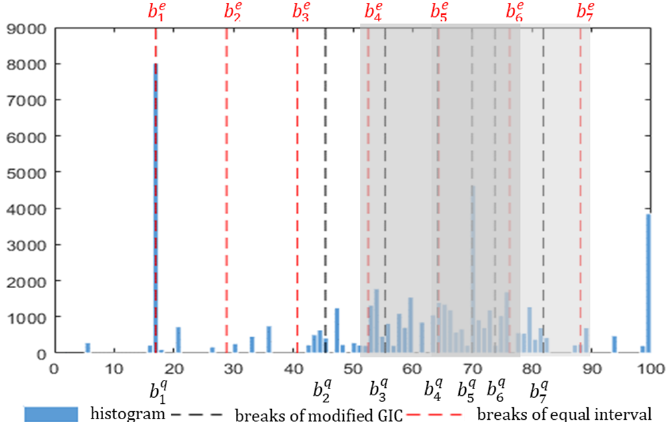
Figure 4. Illustration of determining where and how many times to inverse q in the adaptive GIC for multi-peak data.